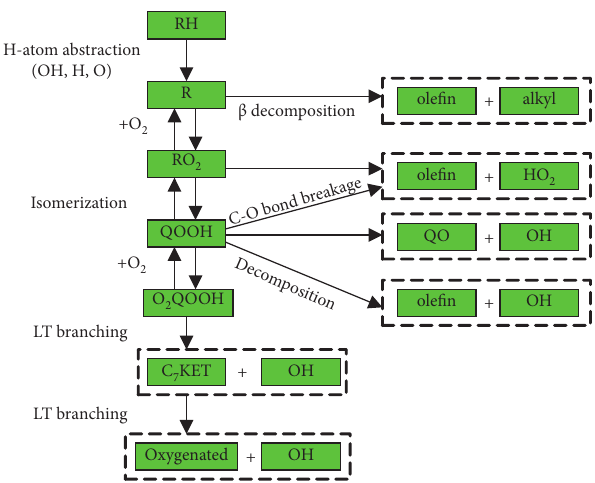
Figure 7: Simplified reaction pathways of n-heptane